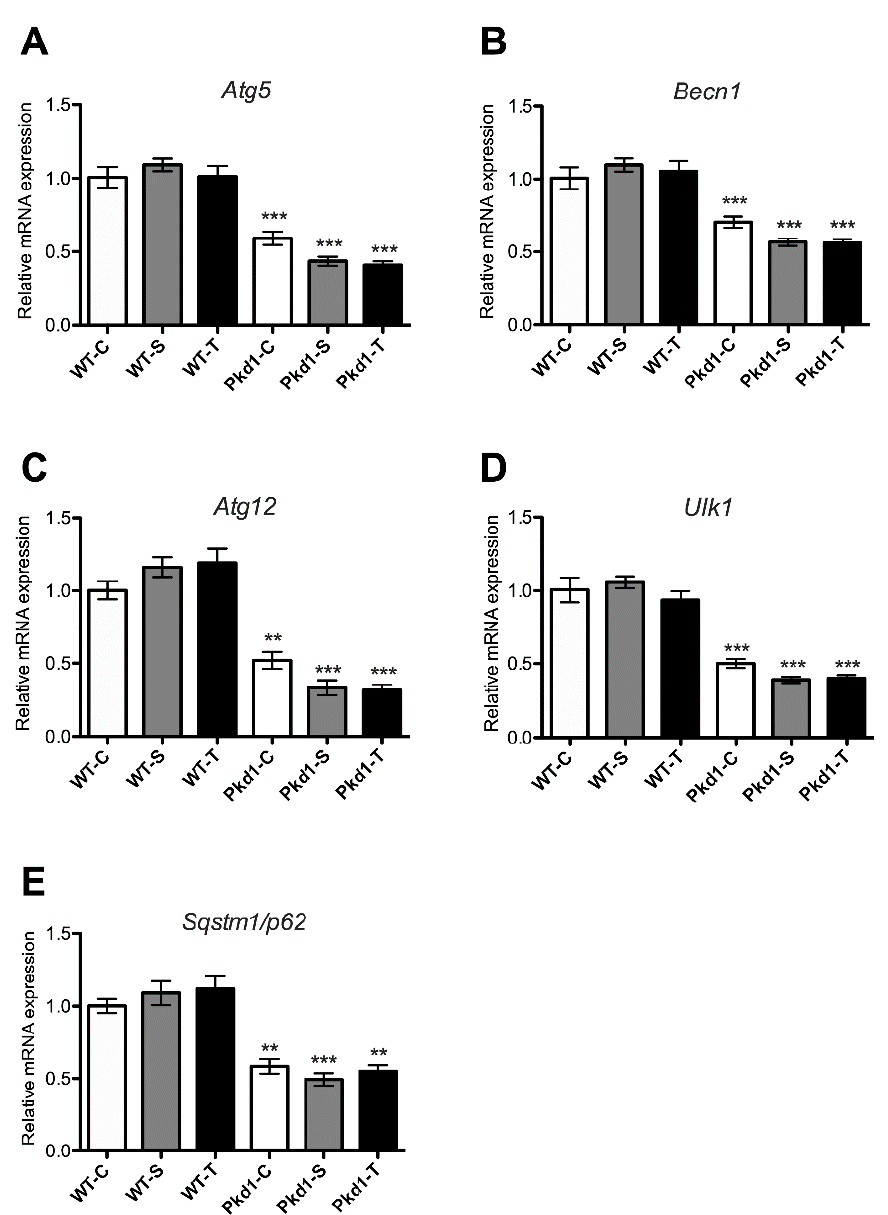
Figure 5. Effect of trehalose on the expression of autophagy-related genes in the kidneys of Pkd1 miRNA transgenic mice. The relative renal mRNA amounts of ( A ) Atg5, ( B ) Becn1, ( C ) Atg12, ( D ) Ulk1, and (E) Sqstm1/p62 in the mice in the different experimental groups compared with wild-type mice ( n = 3, 6, 9, 9, 8, and 7 per group, respectively). ** p < 0.01, *** p < 0.001 compared with the wild-type control group. WT, wild-type; PKD, polycystic kidney disease; C, control; S, sucrose; T,